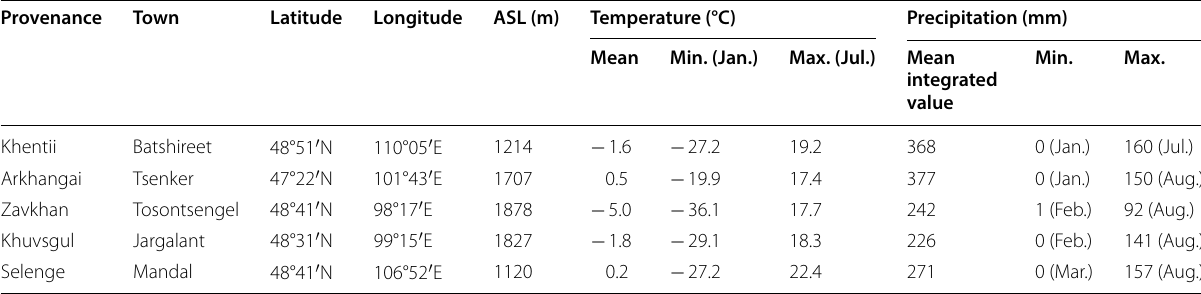
Data on temperature and precipitation were provided from Information and Research Institute of Meteorology, Hydrology and Environment, Mongolia. Mean temperature means annual temperature and was calculated by averaging monthly temperature obtained from 2012 to 2016. Mean integrated values of precipitation were calculated by integrating monthly precipitation values of 1 year (2012 to 2016), and then averaged integrated values of 5 years. Minimum and maximum values of precipitation were mean precipitation in a month ASL: above sea level; min.: minimum; max.: maximum Table 2 Sample trees and logs in the present study [11] Provenance n 1